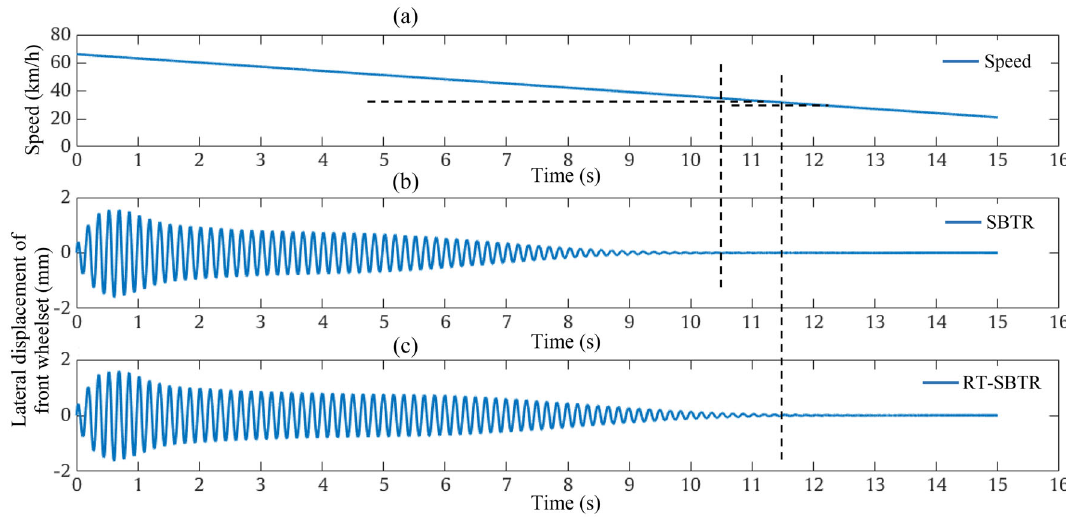
Fig. 13 a Critical speed, lateral displacement of wheelsets at critical speed for b SBTR, and c RT-SBTR